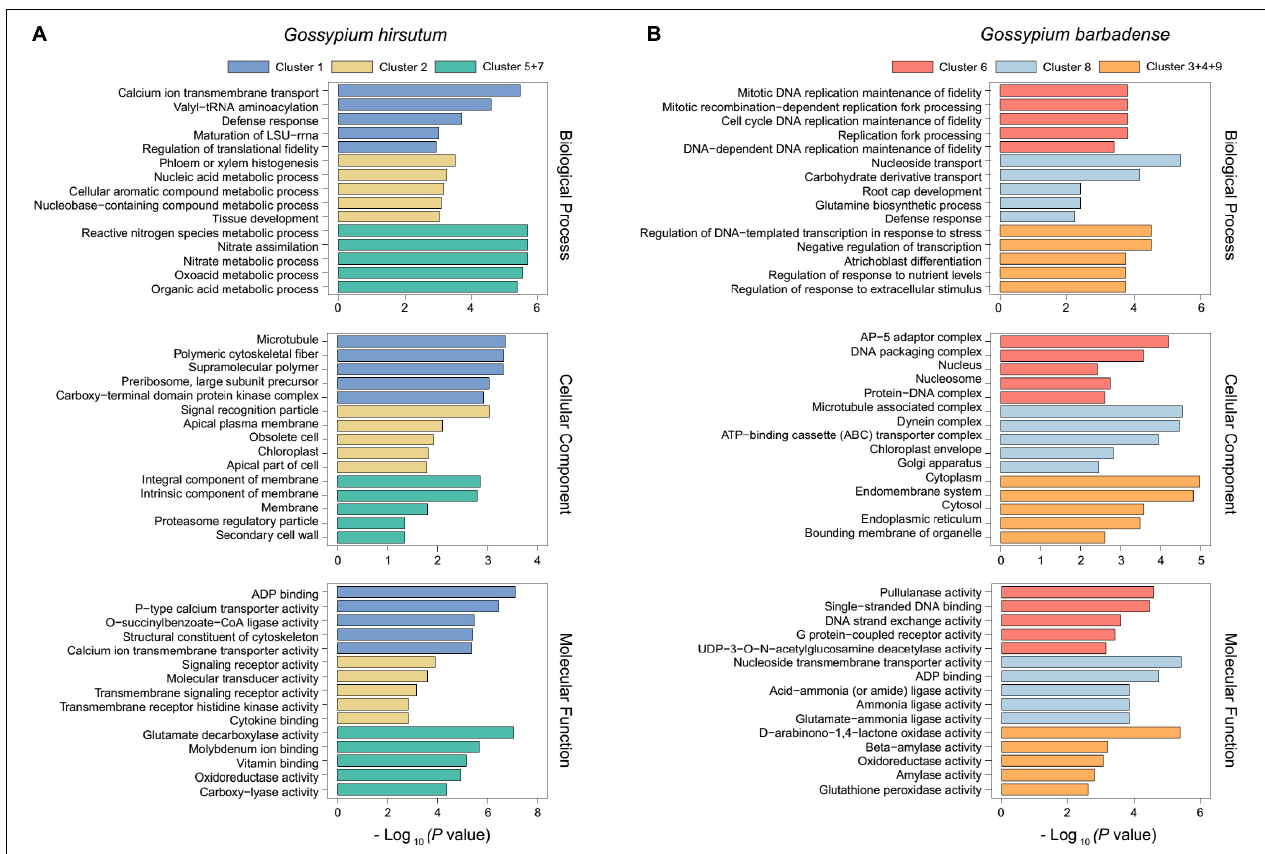
FIGURE 3 | GO enrichment analysis results of predominant expression in G. hirsutum and G. barbadense . GO enrichment analysis results of predominant expression in G. hirsutum (A) and G. barbadense (B) , including the biological process, cellular component, and molecular function. The different colors represent different clusters. The X–axis represents -log 10 ( p –value) and the enriched GO terms are indicated on the